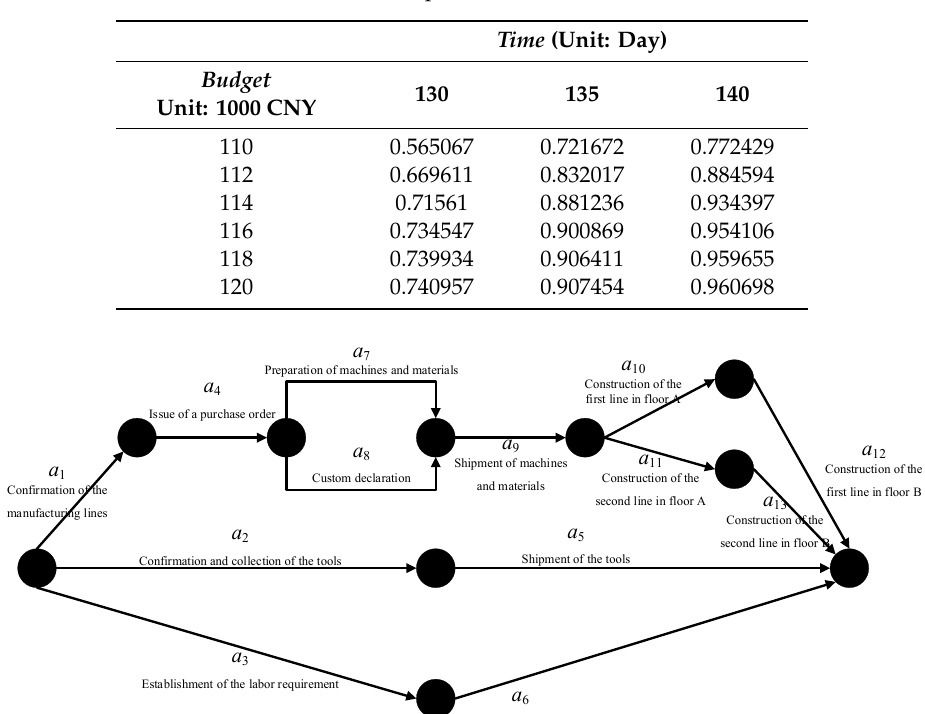
Table 3. Experimental results.